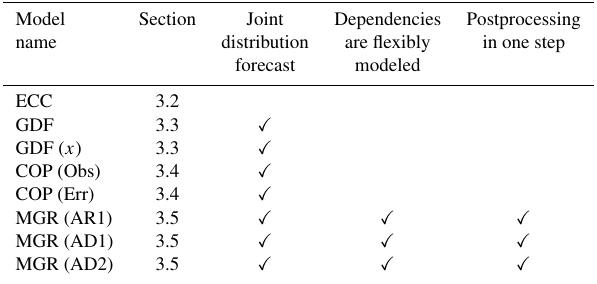
Table 2. Information about the models used for postprocessing mul- tivariate wind speed forecasts including (i) the section in which they are described, (ii) whether or not the postprocessed forecast is a joint probability density function, (iii) whether or not dependencies are flexibly modeled, and (iv) if postprocessing is a one-step proce- dure or marginal distributions and their dependencies are treated in separate